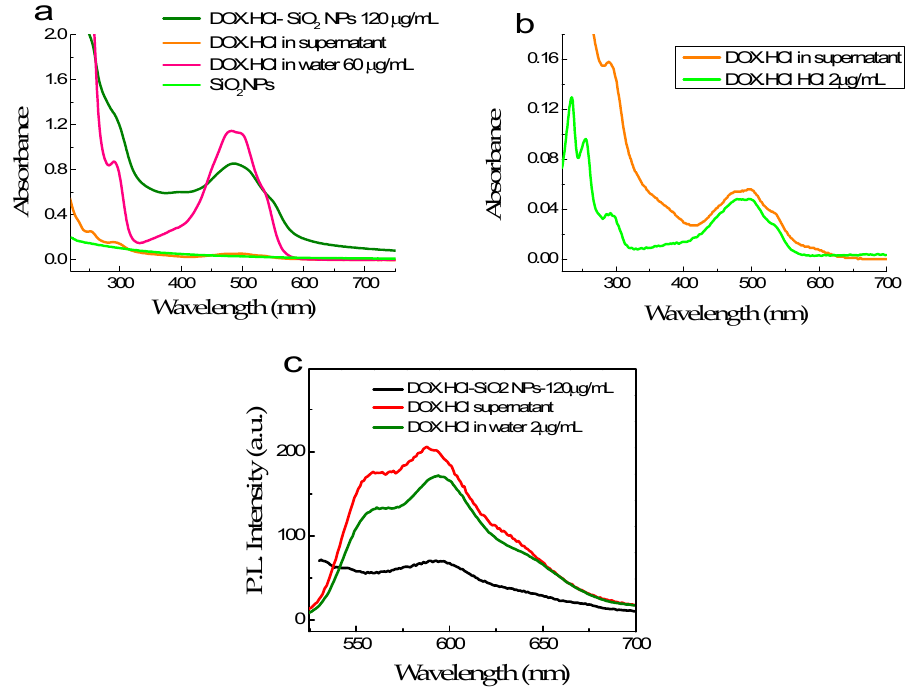
Figure 5. The absorption spectra of SiO 2 NPs, 120 µ g/mL DOX · HCl absorbing on SiO 2 NPs and residual DOX · HCl content in supernatant compared with those of free DOX · HCl at 60 µ g/mL, and the residual DOX · HCl in the supernatant ( a ); the absorption of DOX · HCl in supernatant compared with those of free DOX · HCl at 2 µ g/mL in aqueous solution ( b ); and the fluorescence spectra of three above solutions ( c ).